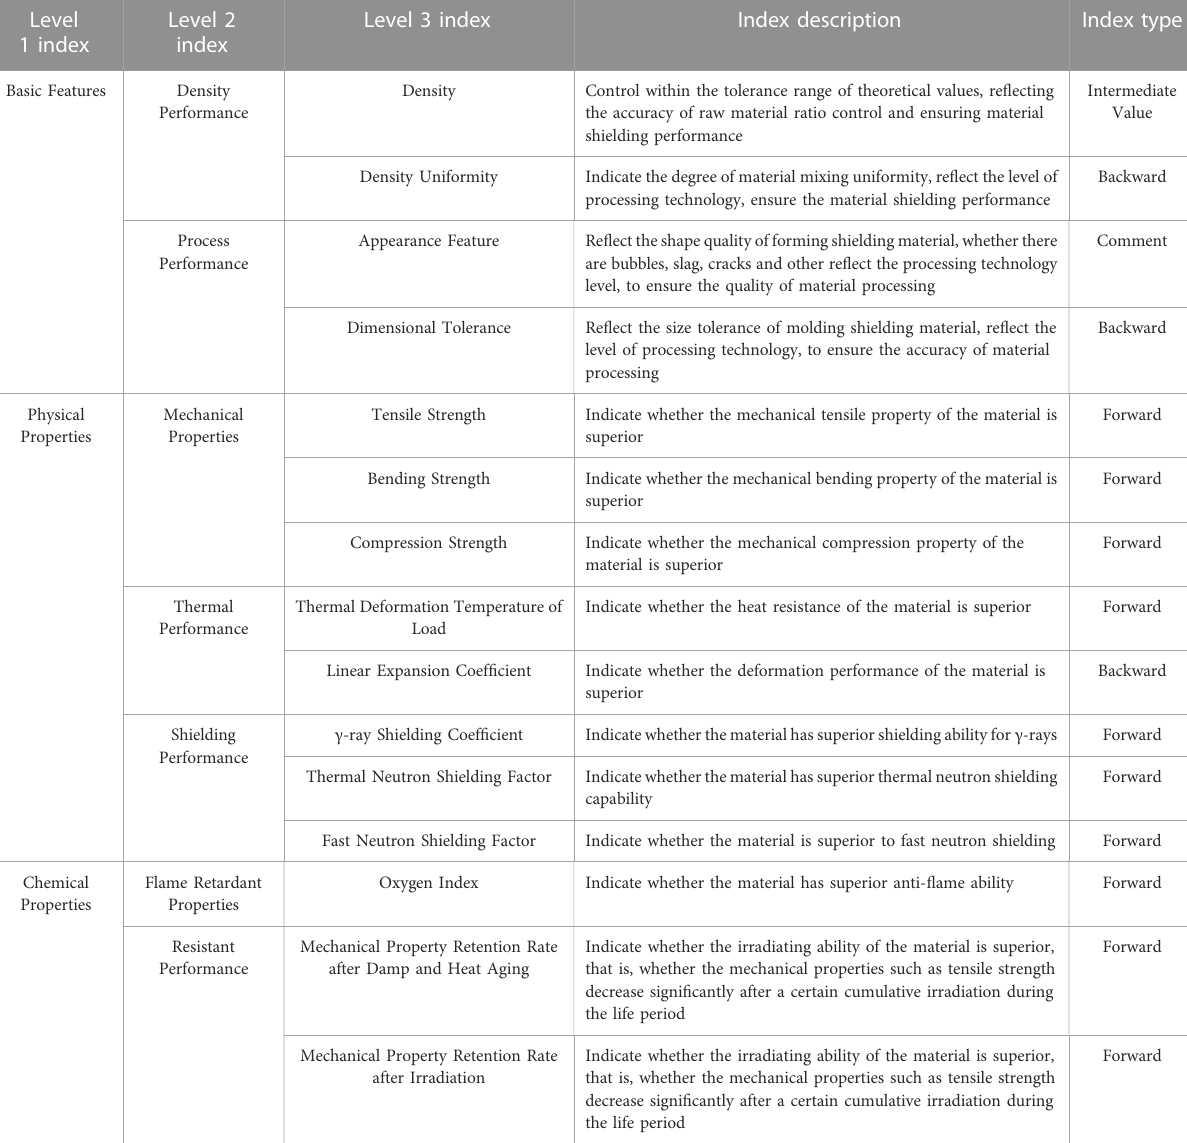
TABLE 1 Composite shielding material performance evaluation index system and index